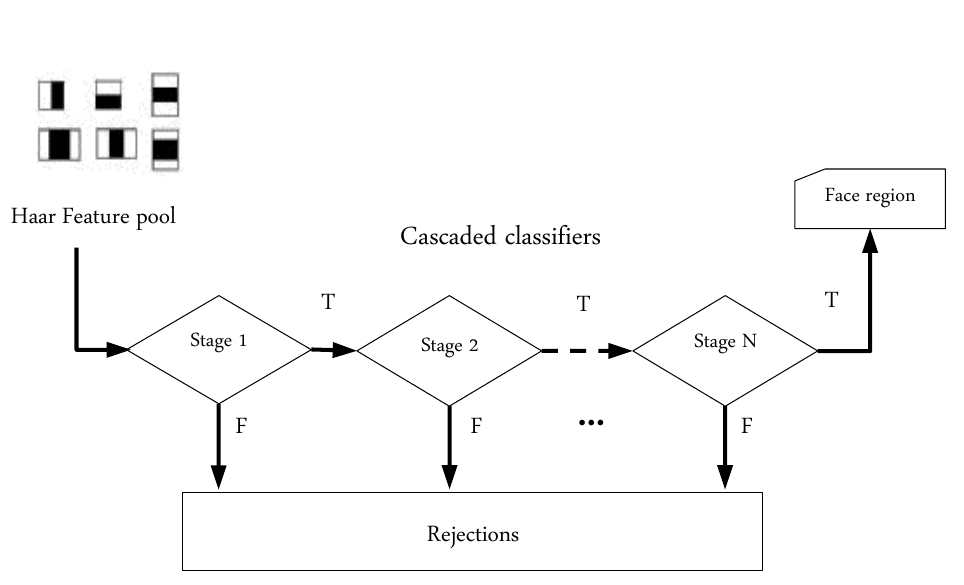
Figure 3. The cascade structure of adaBoost classifier for face detection.